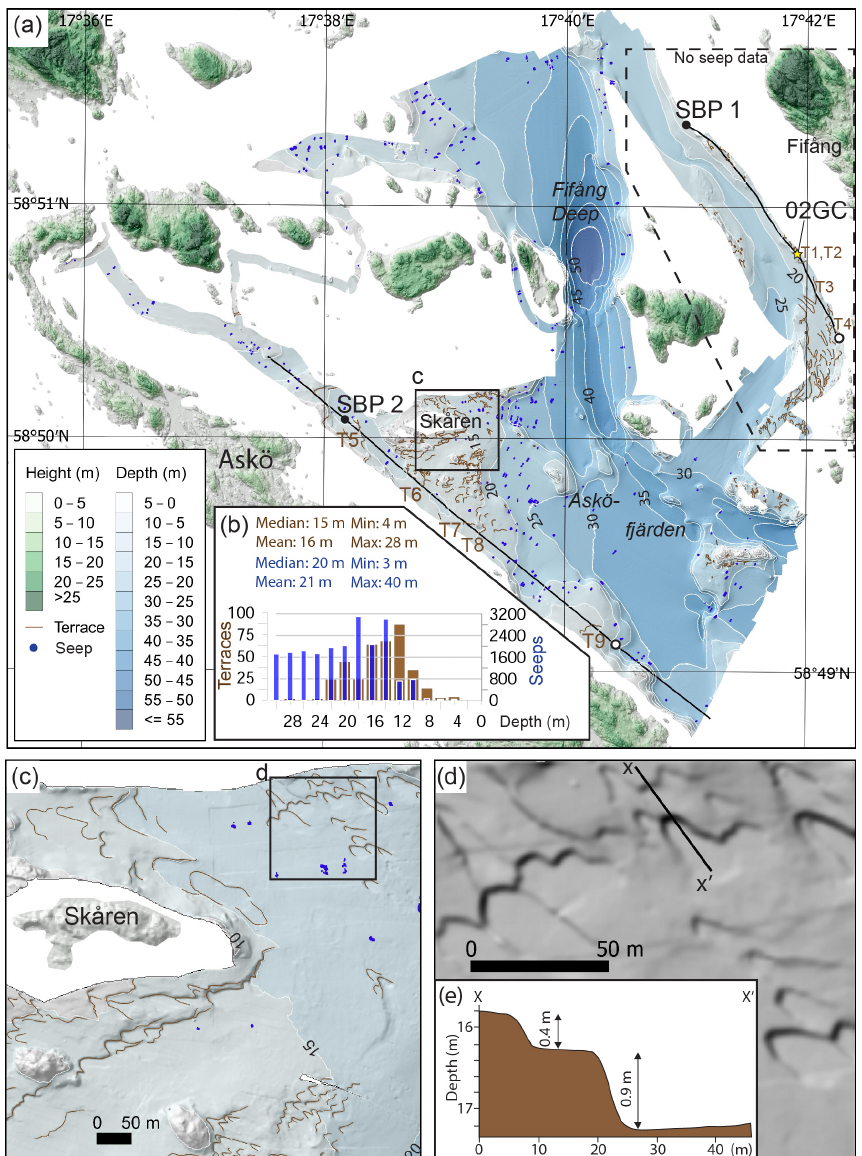
Figure 2. Multibeam bathymetry of the studied area east of the island of Askö, southern Stockholm archipelago. (a) Overview map with brown lines representing digitized terraces in the sea floor and blue dots showing locations where seeps were identified in the multibeam water column data. Black heavier lines show the locations of the sub-bottom profiles in Fig. 5a (SBP1) and b (SBP2). The sub-bottom profiles in Fig. 5 are portrayed between the two dots, with the profile running from left (black dot) to right (white dot). The location of core Asko2018HT-2GC is marked by a yellow star (abbreviation 02GC used on the map). (b) Depth statistics of the occurrence of terraces and seeps. (c) Detailed view of the terraces in the sea floor around the island of Skåren. (d) The location of the bathymetric profile across two terraces from X to X (cid:48) shown in (e)